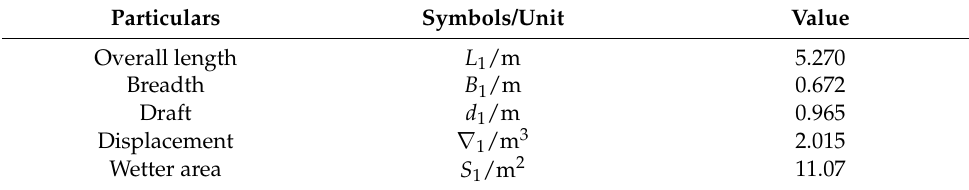
Table 3. Main particulars of the rear